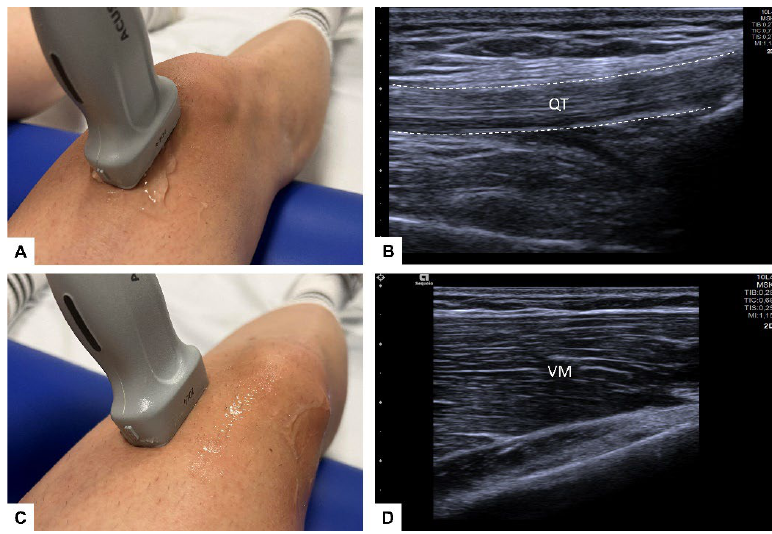
Figure 1. Probe placement and target volume: for SWE, a multifrequency linear transducer was placed in longitudinal plane for accurate assessment of the quadriceps tendon (QT; ( A , B )) and with minimal movement to assess the medial vastus muscle (VM; ( C , D )).